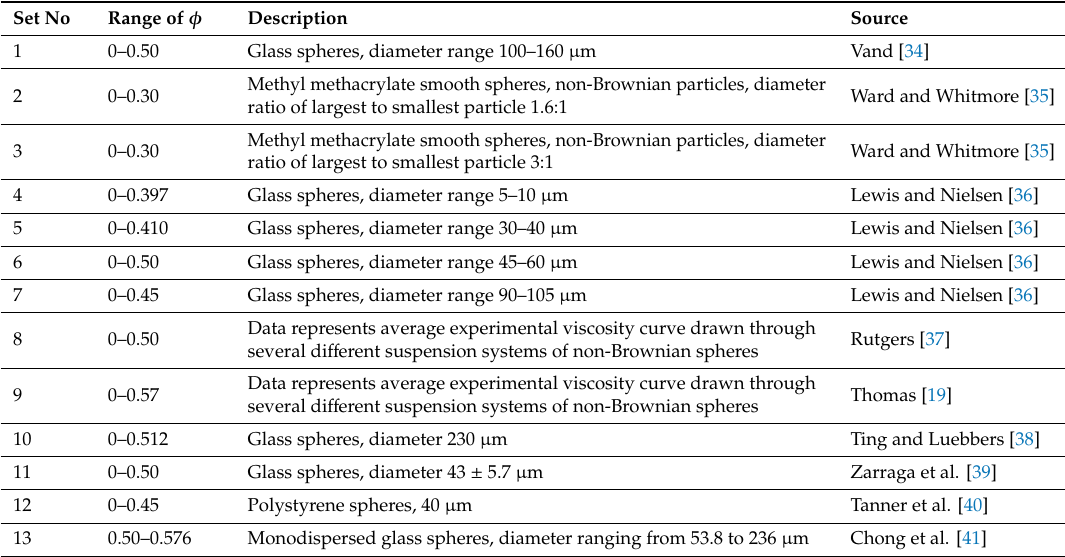
Table 2. Summary of various suspension systems considered in evaluating the viscosity